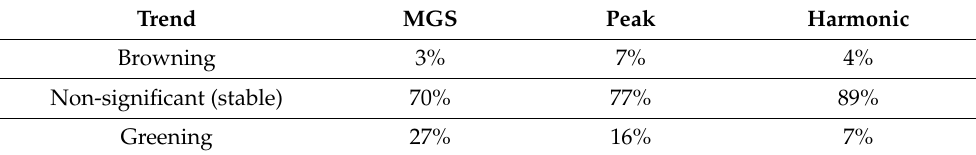
Table 3. Greening and browning distribution for the three trend parameters individually. Trend MGS Peak Harmonic Browning 3% 7% 4% Non-significant (stable) 70% 77% 89% Greening 27% 16%